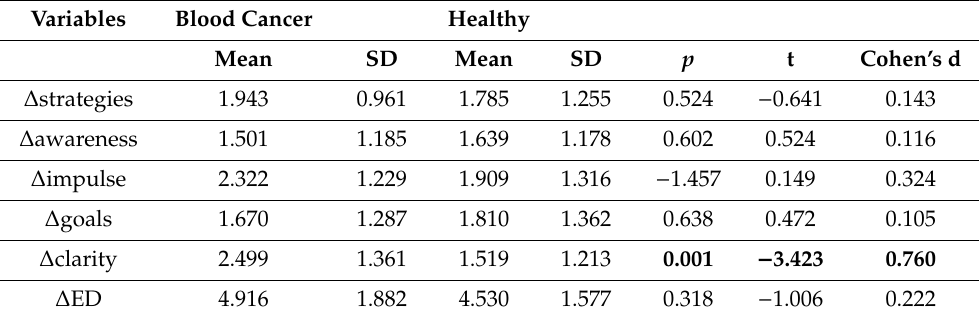
Table 10. Di ff erences between groups: independent samples t -test and Cohen’s d coe ffi cient. Gr. 1: blood cancer patients, n = 46; Gr. 2: healthy persons, n = 49.